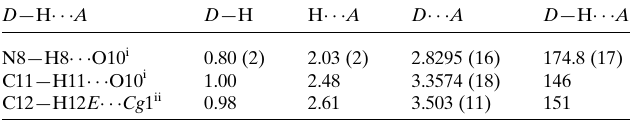
Table 2 Hydrogen-bond geometry (A˚ , (cid:2) ) for 1a . Cg 1 is the centroid of the C1–C6 ring.